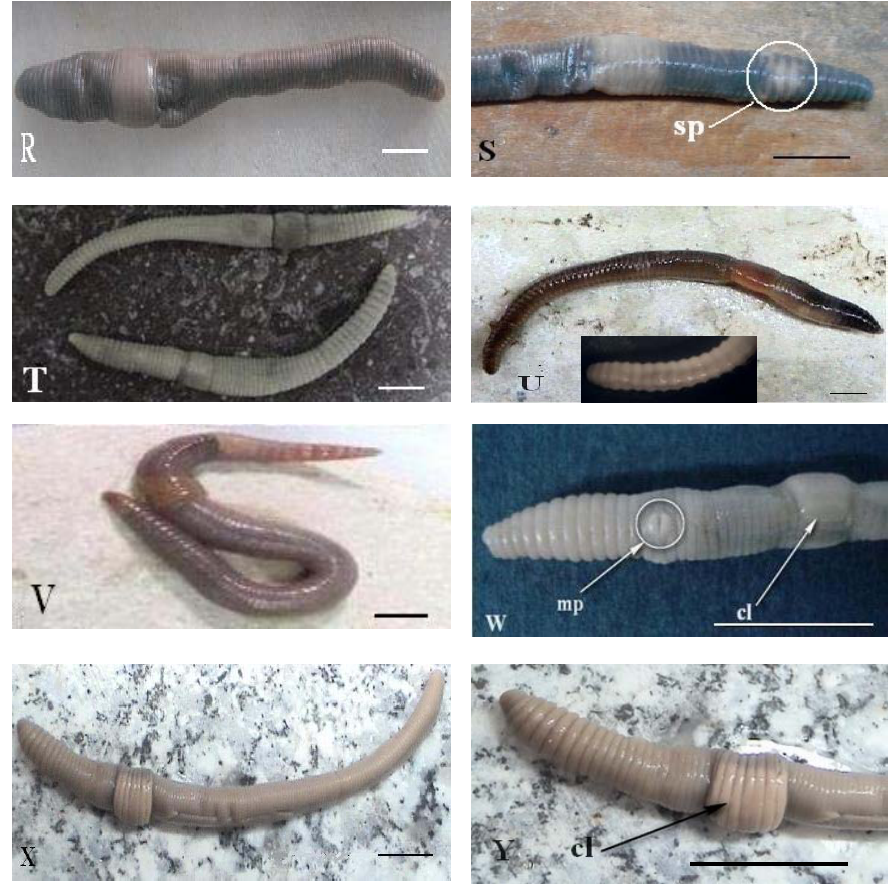
F IGURE 2.- R,S) Eisenia fetida (sp: spermatecha pores), T,U) Eiseniella tetraedra , V,W) Octolasion lacteum (mp: male pore, cl: clitellum) , X,Y) Perelia kaznakov i (cl: clitellum) scale = 1